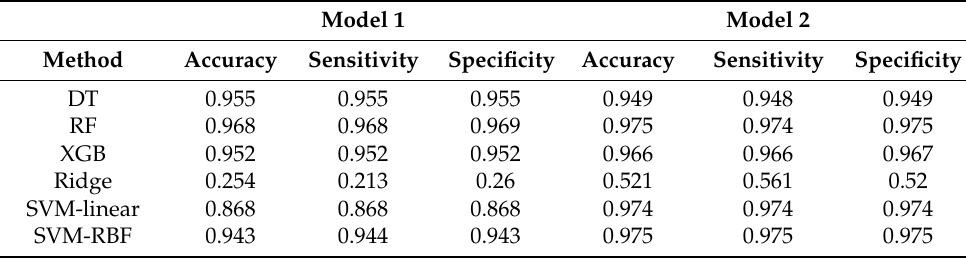
Table 7. Validation results of the spill location prediction models.